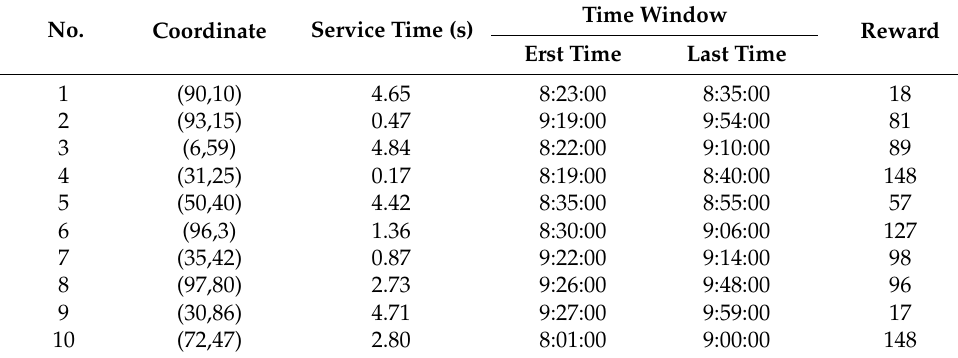
Table 7. Parameter of Tasks.